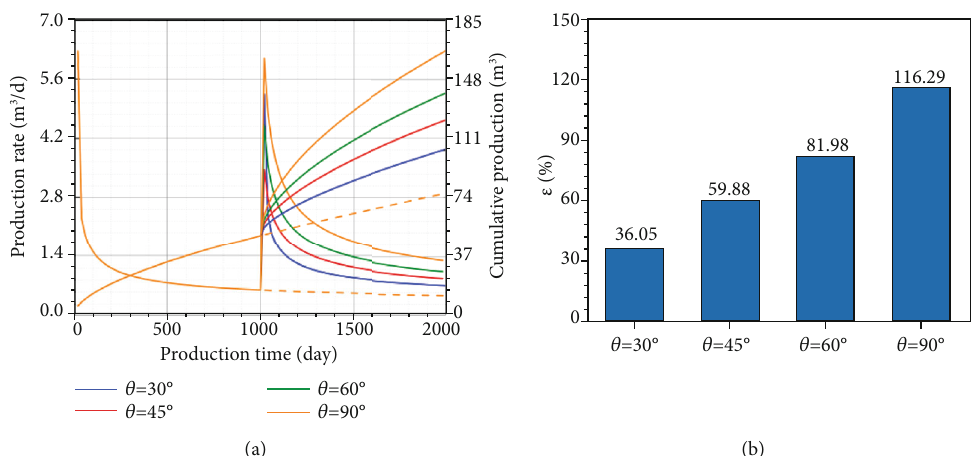
Figure 5: Performance of the refracturing treatment with di ff erent refracture azimuths: (a) production rate and cumulative production and (b) comparison of the increase ratio.